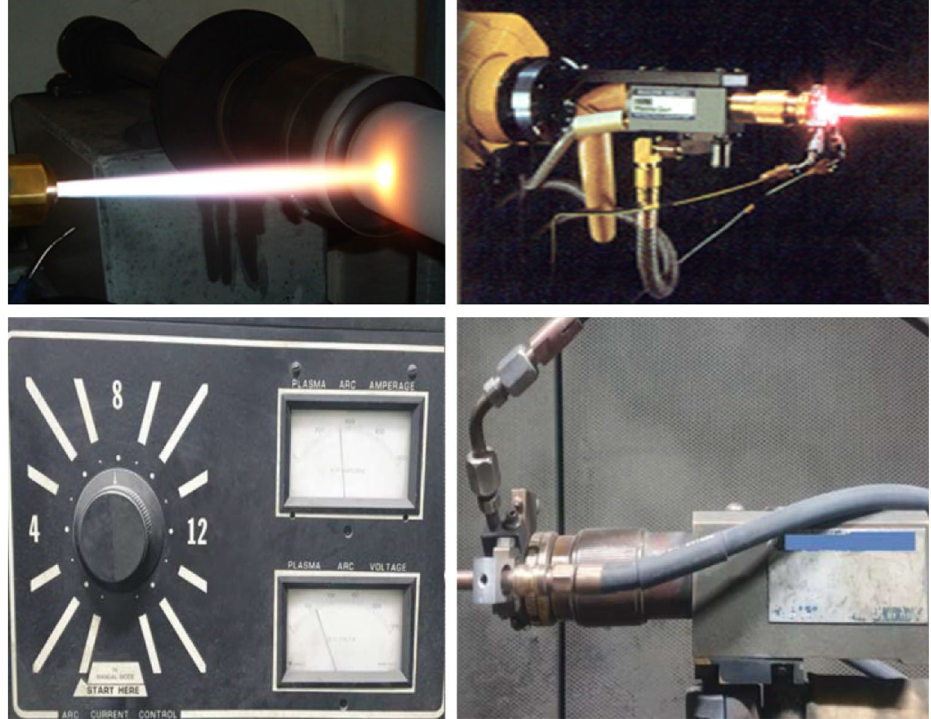
Figure 6. Equipment and control devices used in plasma thermal spraying